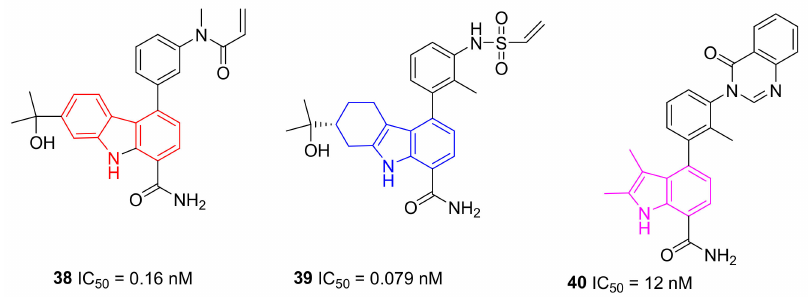
Figure 11. Carbazole, tetrahydrocarbazole and indole